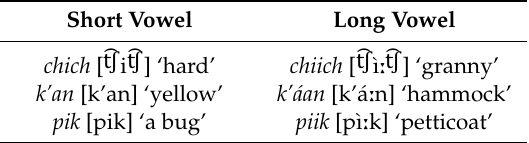
Table 1. Yucatec Maya examples of phonemic short / long vowel contrasts.